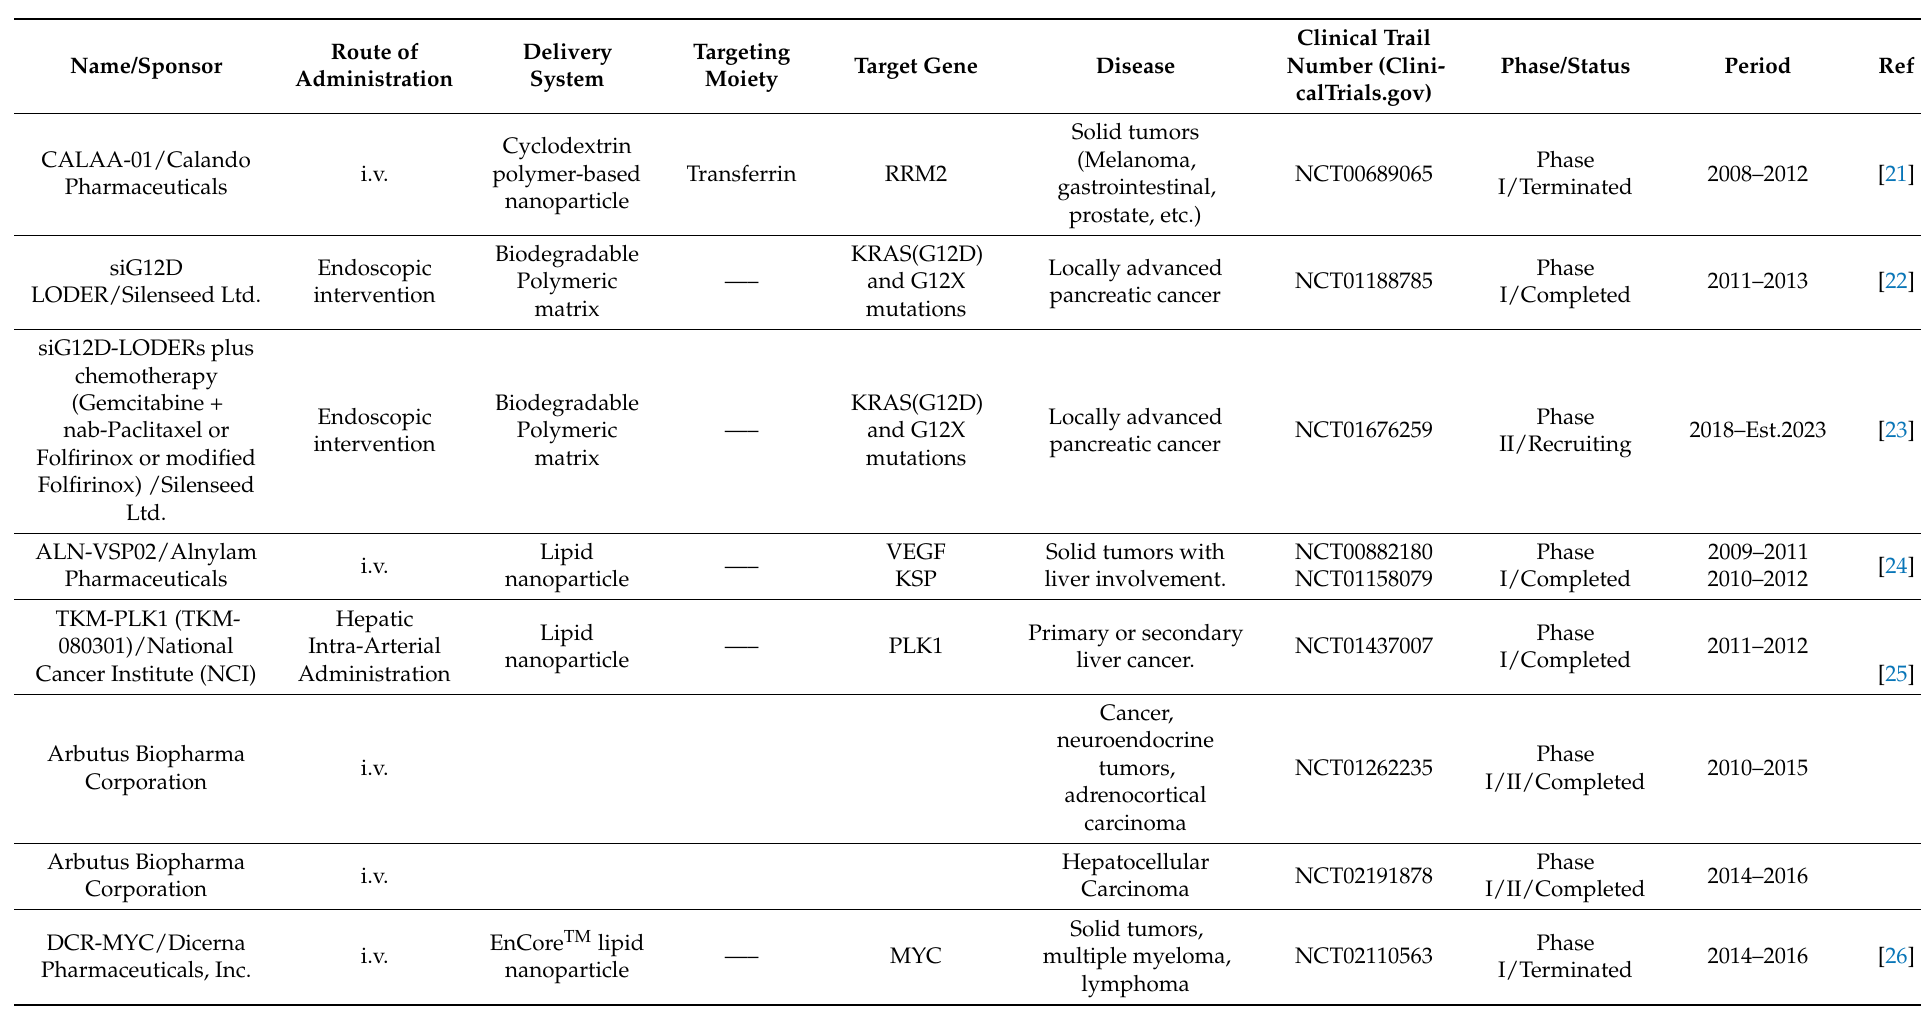
Table 1. Anticancer siRNA-based therapeutics in clinical